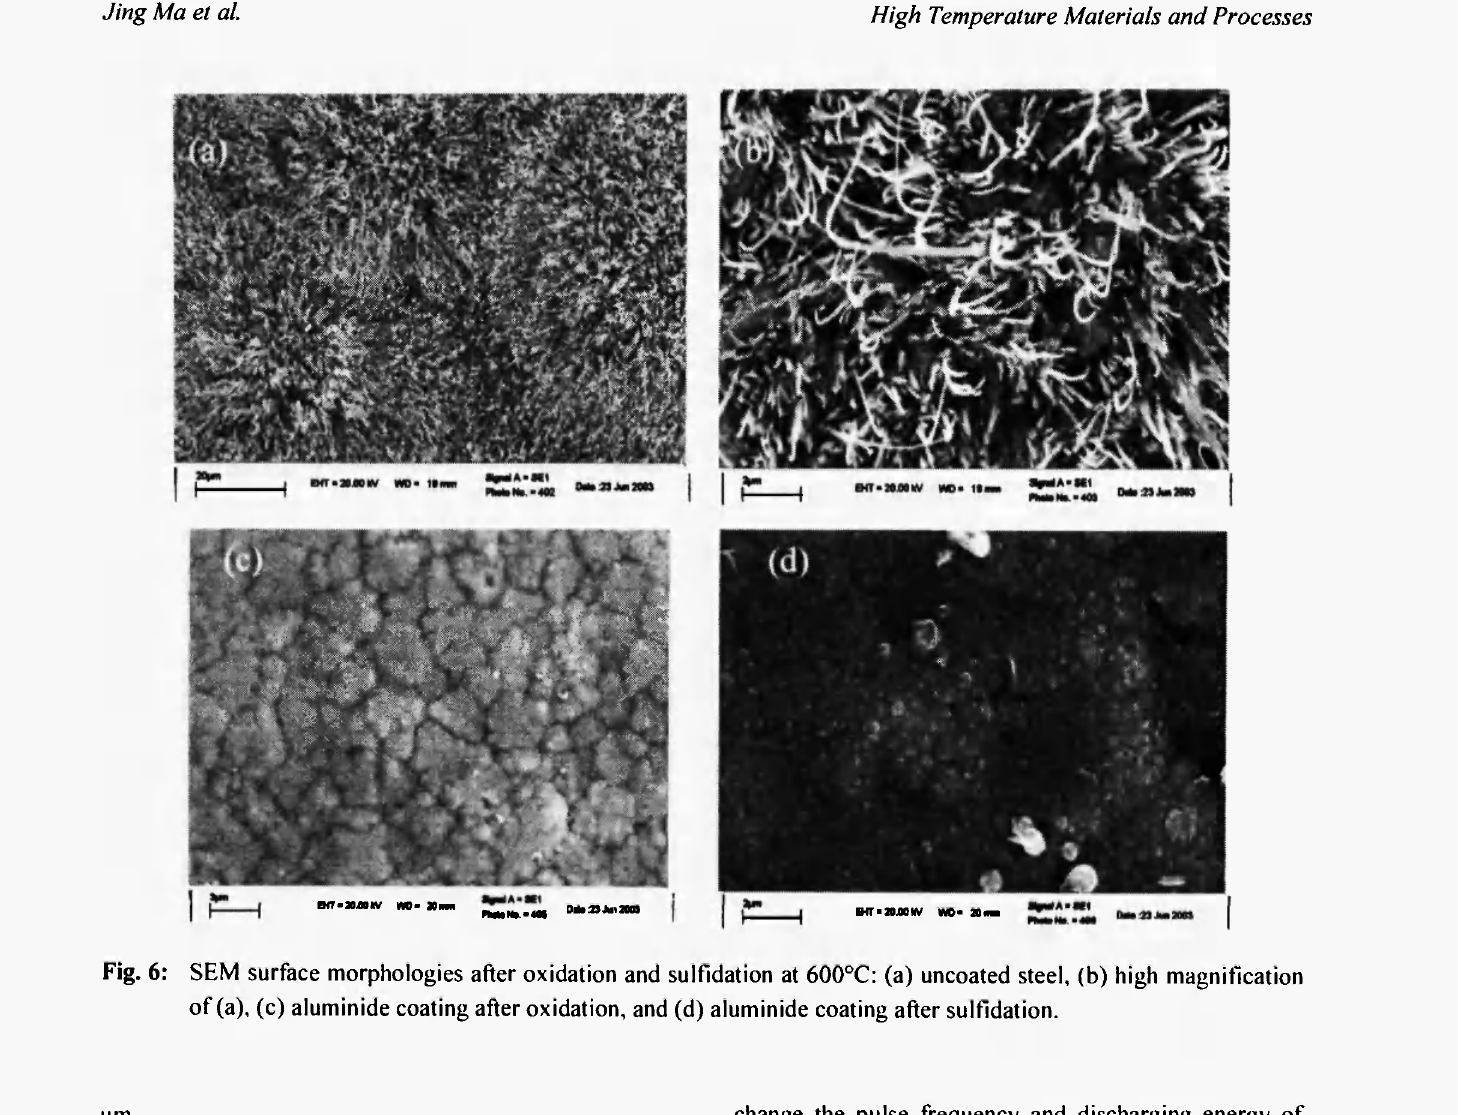
Fig. 6: SEM surface morphologies after oxidation and sulfidation at 600°C: (a) uncoated steel, (b) high magnification of (a), (c) aluminide coating after oxidation, and (d) aluminide coating after sulfidation.